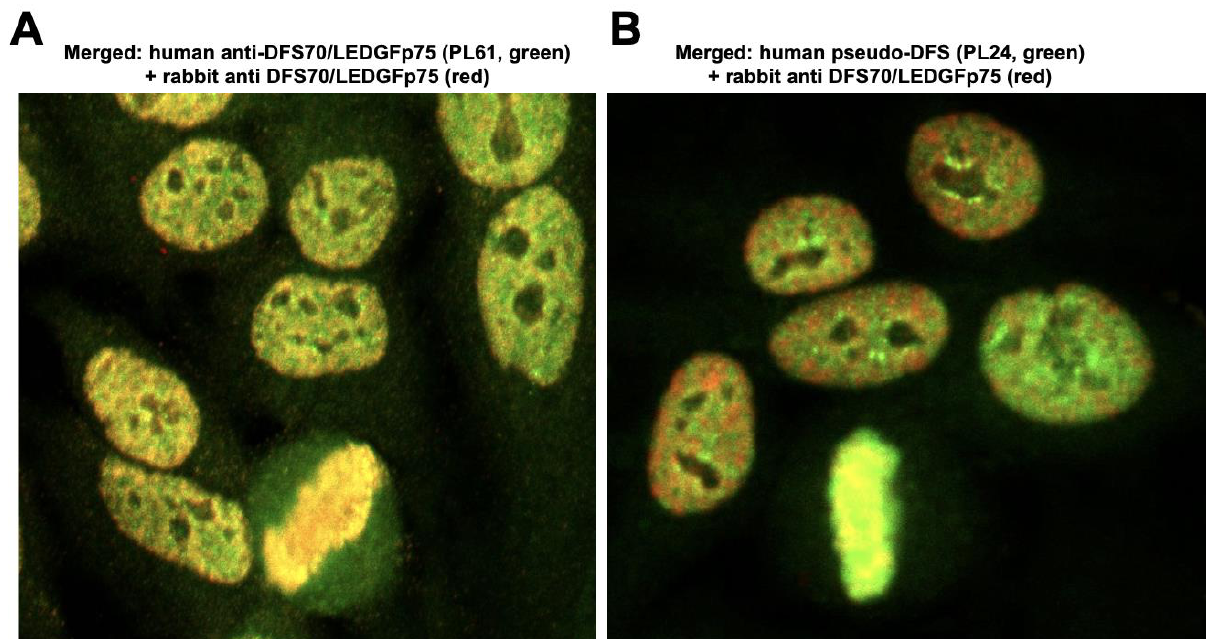
Figure 4. Enlarged fields showing the co-localization of the IFA patterns produced by the monospe- cific CLIA anti-DFS70-positive serum PL61 and CLIA anti-DFS70-negative serum PL24 with the DFS pattern produced by anti-DFS70/LEDGFp75 rabbit antibodies. ( A ) Merged image of serum PL61 (green) co-incubated with anti-DFS70/LEDGFp75 rabbit antibody (red) in the standard HEp-2 test. Extensive co-localization can be observed, as evidenced by the yellow/orange fluorescence. ( B ) Merged image of serum PL24 (green) co-incubated with anti-DFS70/LEDGFp75 rabbit antibody (red). The co-localization was less extensive, as evidenced by the increased separation of the red and green fluorescence. Images were obtained by confocal microscopy.